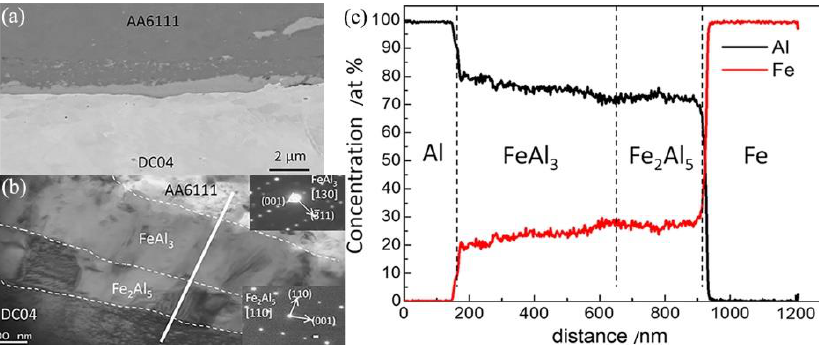
Figure 14. ( a ) SEM images of the IMC reaction layers; ( b ) TEM images of the IMC reaction layers; ( c ) results from EDX composition line scans obtained by TEM across the IMC interface layers [44].